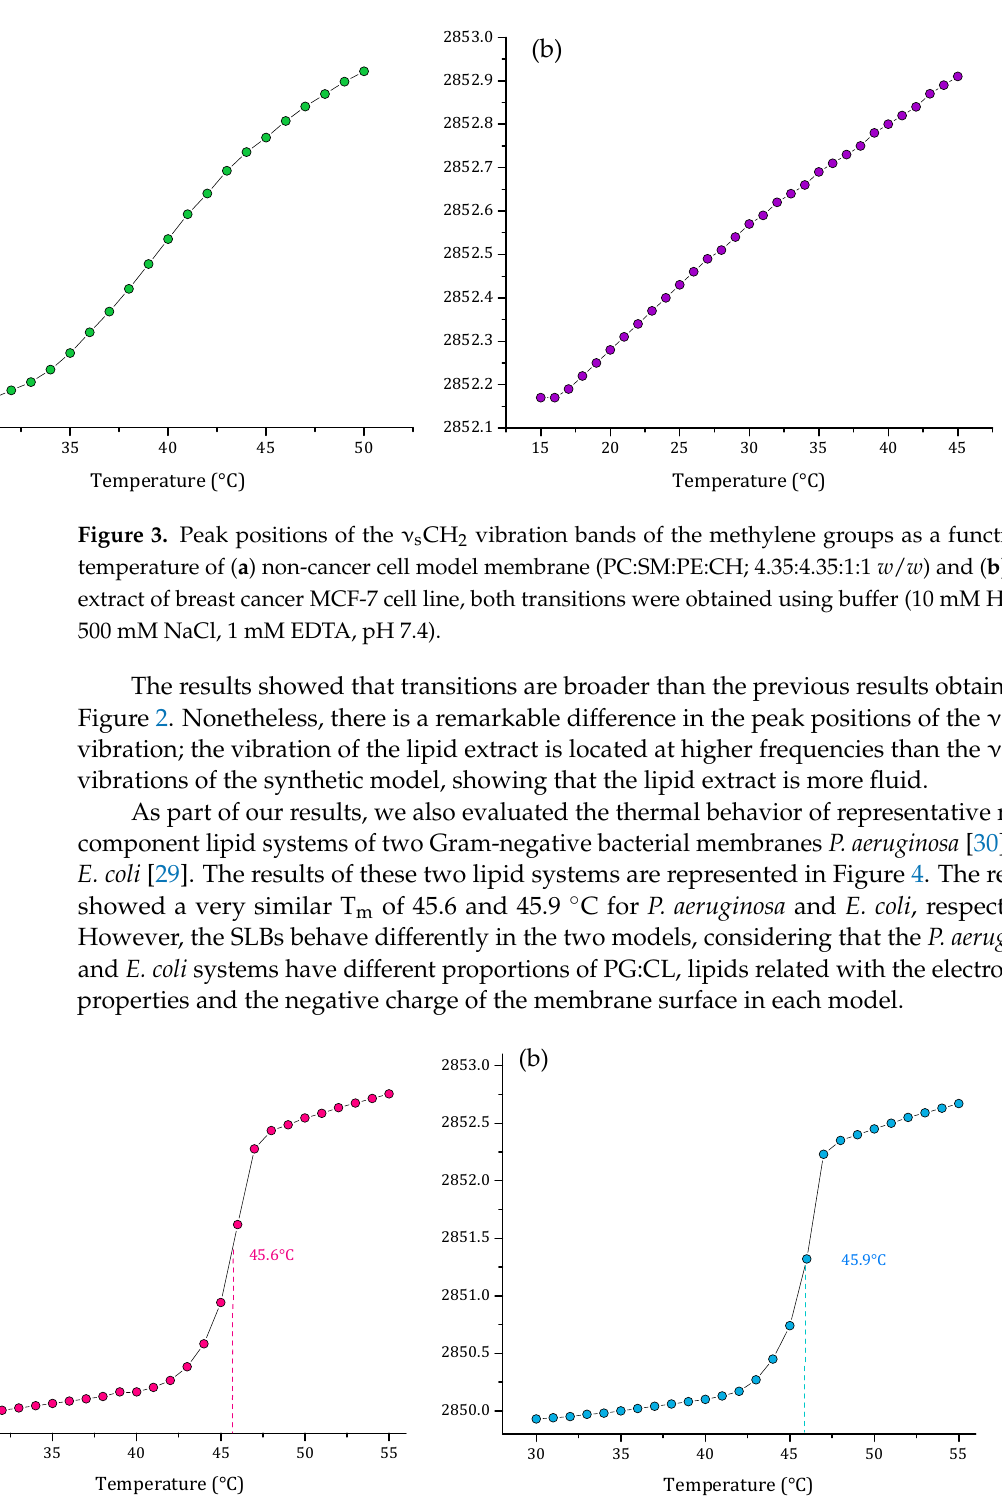
Figure 4. Peak positions of the ν s CH 2 vibration bands of the methylene groups as a function of temperature of ( a ) P. aeruginosa PE:PG:CL 65:23:12 ( w / w ) and ( b ) E. coli PE:PG:CL 75:20:5 ( w / w ) multi-component lipid systems in 10 mM HEPES, 500 mM NaCl, 1 mM EDTA, pH 7.4.